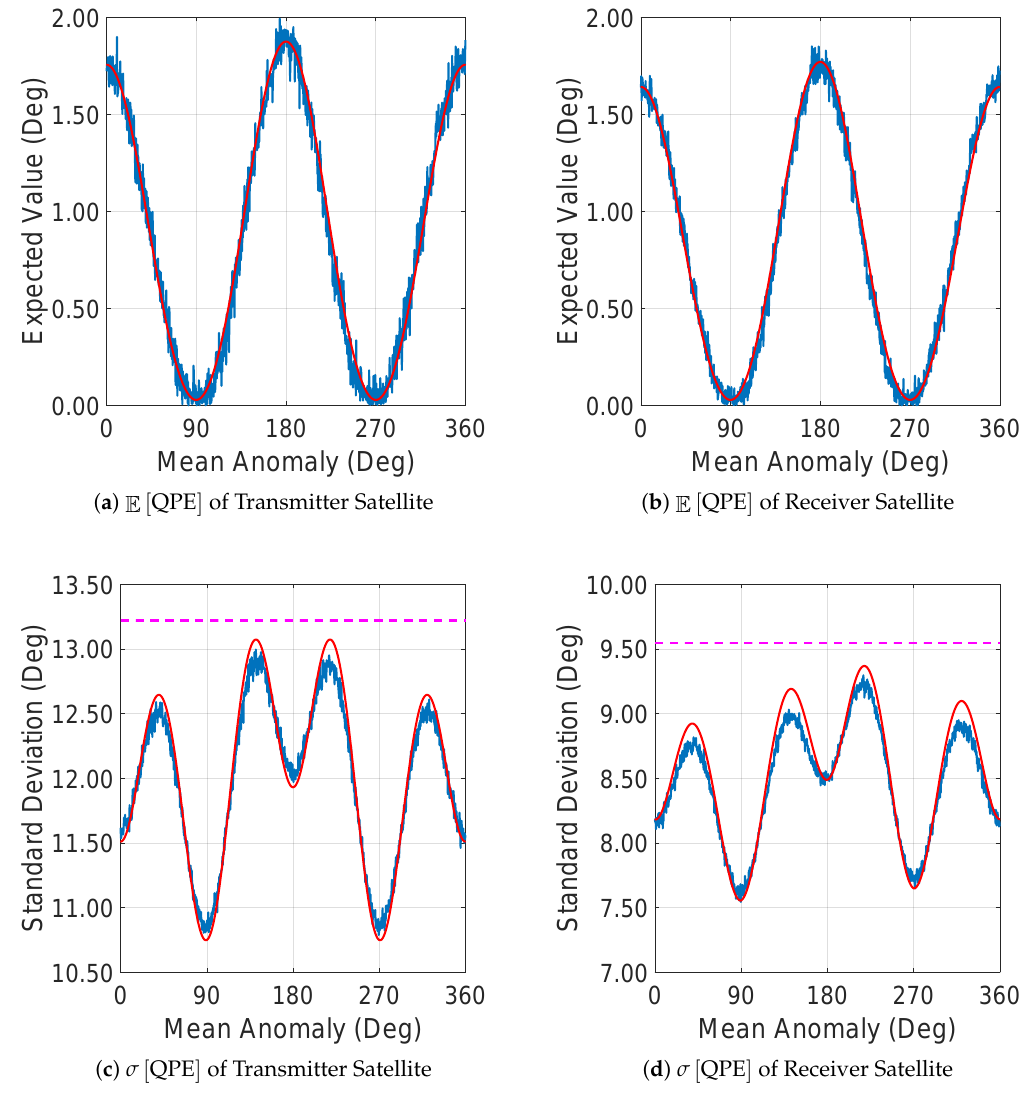
Figure 3. QPE estimation result from Monte Carlo numerical simulation (blue) and the BiAAM (red). ( a , b ) present the expected value of QPE of the transmitter and receiver satellites, while ( c , d ) show the standard deviation of QPE of the transmitter and receiver satellites, respectively. The dashed magenta lines in ( c , d ) are the values of σ [ QPE ] of the transmitter and receiver satellites from max Equation (35),